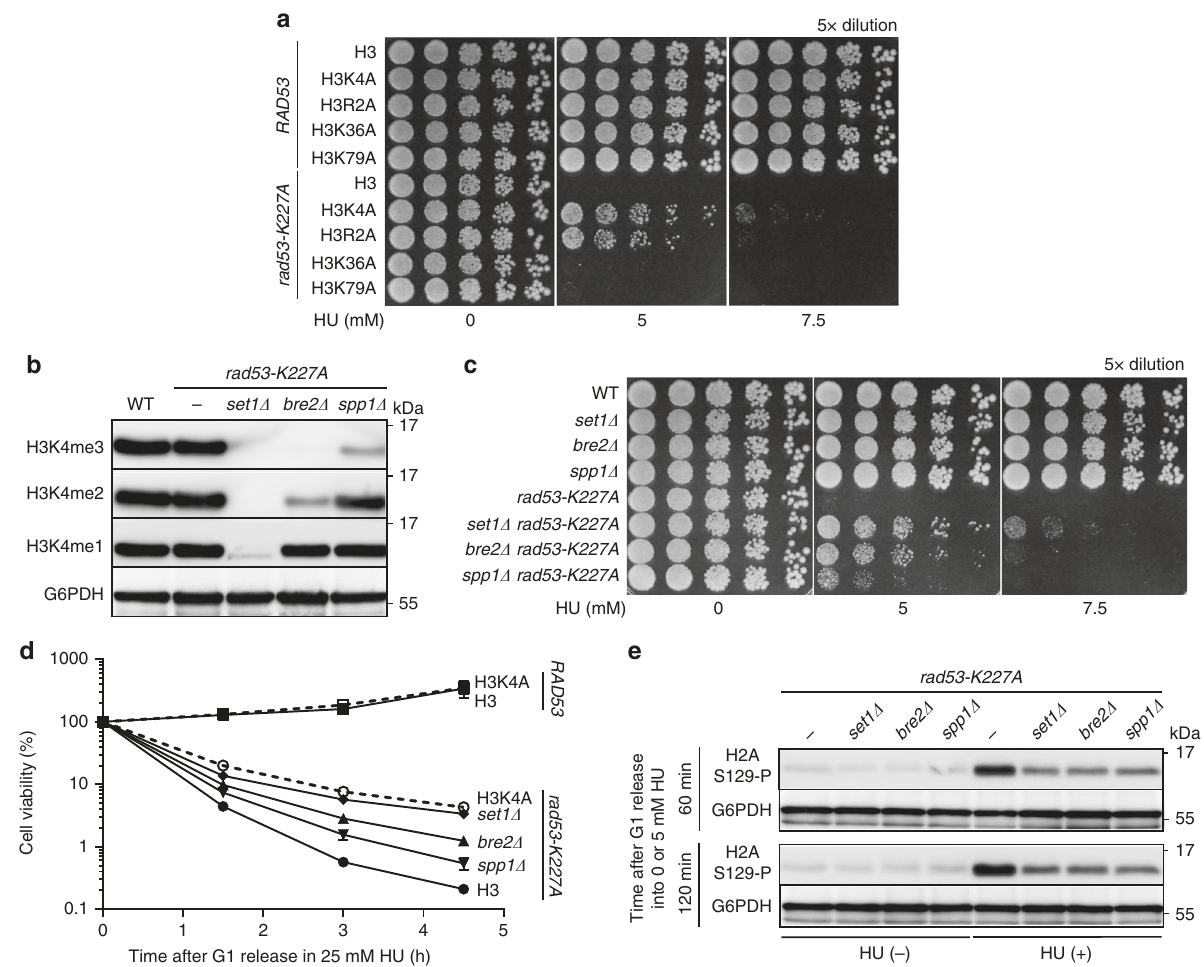
Fig. 1 Decreased H3K4 methylation level improves viability of rad53 mutants exposed to HU-induced replication stress. a HU sensitivity was determined with H3 (WT), H3K4A, H3R2A, H3K36A and H3K79A mutations in the RAD53 or rad53-K227A backgrounds. b Immunoblot showing H3K4me1/2/3 levels in set1 Δ bre2 Δ and spp1 Δ strains. c HU sensitivity was determined with WT, set1 Δ , bre2 Δ , and spp1 Δ in the RAD53 or rad53-K227A backgrounds. d Cell viability after G1 synchronization and release into 25 mM of HU for the indicated time for H3, H3K4A, set1 Δ , bre2 Δ and spp1 Δ on RAD53 or rad53-K227A backgrounds. Data are the mean ± SD ( n = 3 biological replicates). e Immunoblot showing levels of phosphorylated H2AS129 ( γ H2A) in set1 Δ , bre2 Δ and spp1 Δ on the rad53-K227A background after G1-release in 0 mM ( − ) or 5 mM HU ( + ) for the indicated kinase function nor H3K4 methylation had a signi fi cant effect on global Rpb3 binding pro fi les in open reading frames (ORFs) (Fig. 2a) after exposure to 25 mM HU for 2 h. We further ana- lyzed the Rpb3 distribution by dividing all ORFs into quintiles according to their expression ef fi ciency (see Methods section).